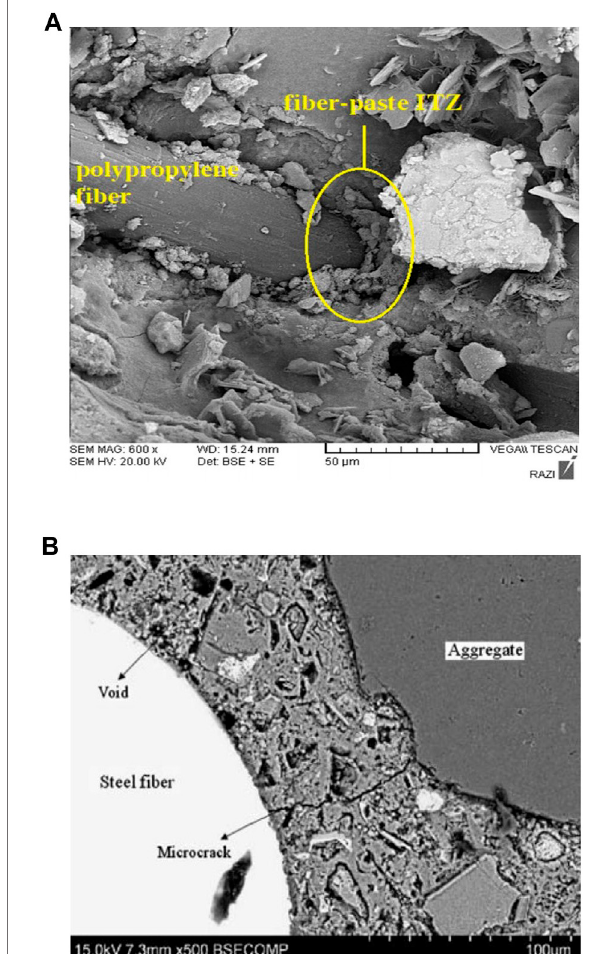
FIGURE 7 | SEM images of (A) ITZ between fi ber and matrix (Behforouz et al., 2020), and (B) crack isolator role played by fi ber (Wang et al., 2020).